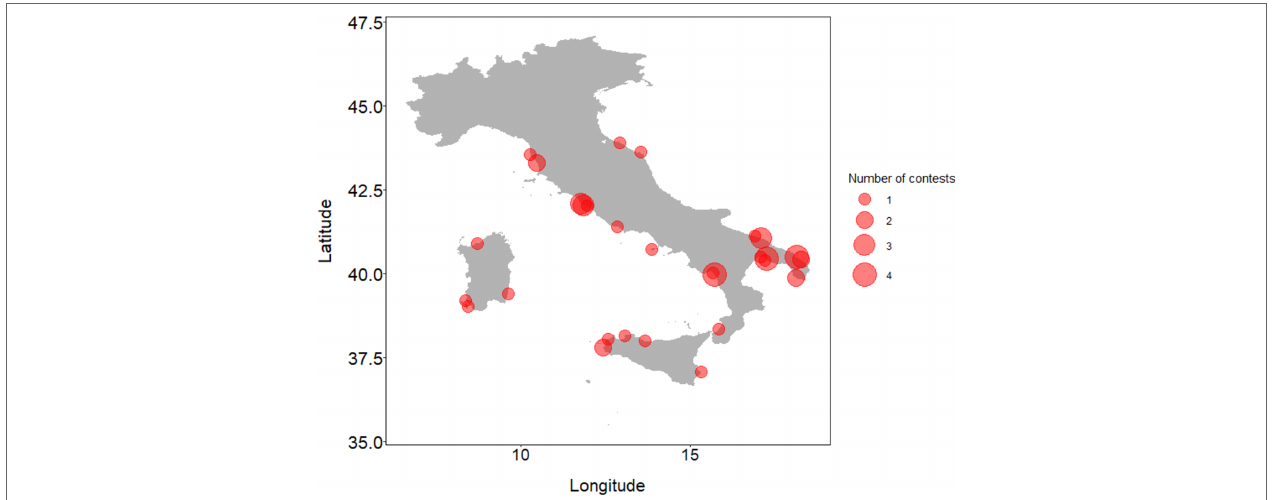
FIGURE 1 | Geographical distribution of the marine spearfishing tournaments analysed in this study (N = 48).